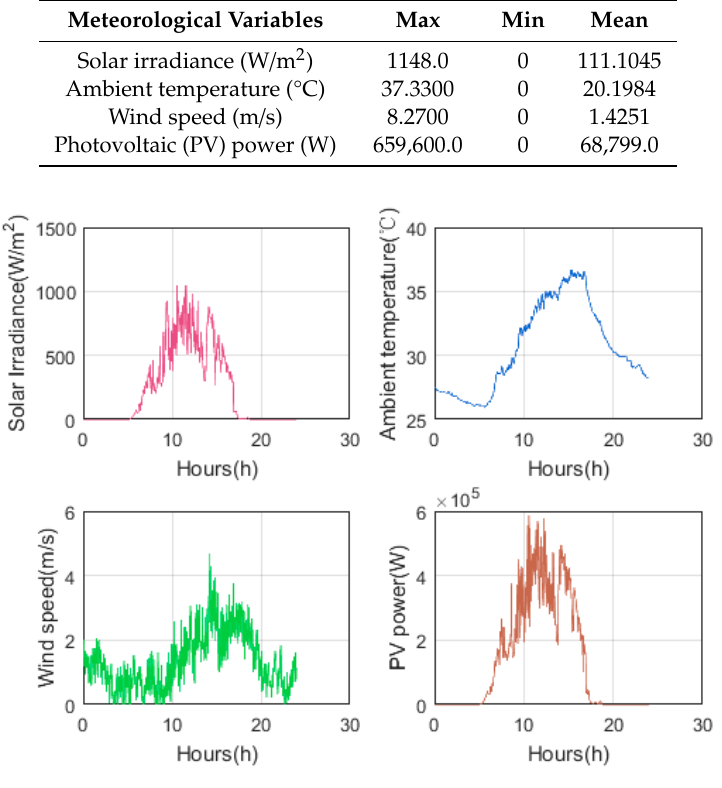
Figure 1. Samples of the raw data from 24 June 2015 00:00:00 to 24 June 2015 23:59:00.